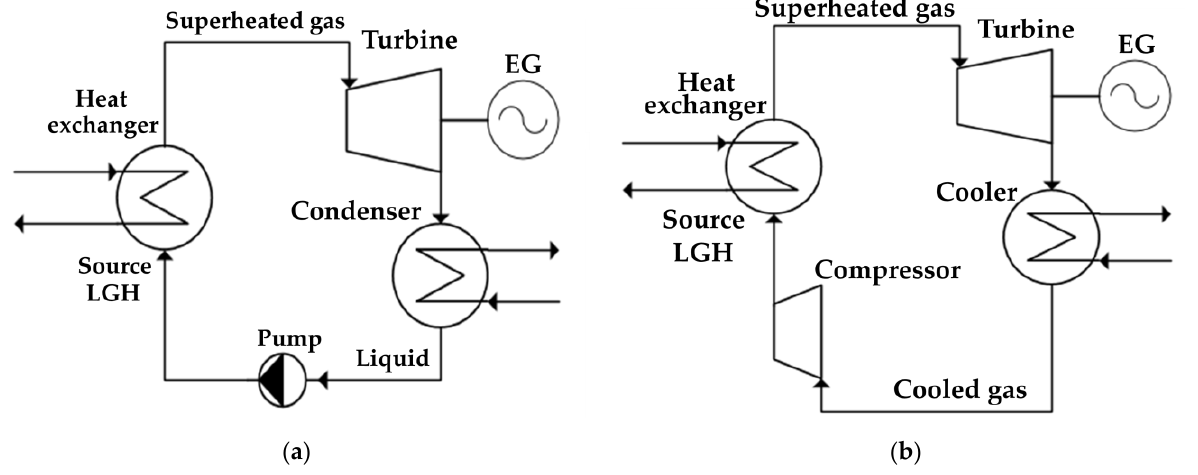
Figure 2. Schemes of cycles with a low-boiling coolant: ( a ) Rankine cycle; ( b ) Brayton cycle.